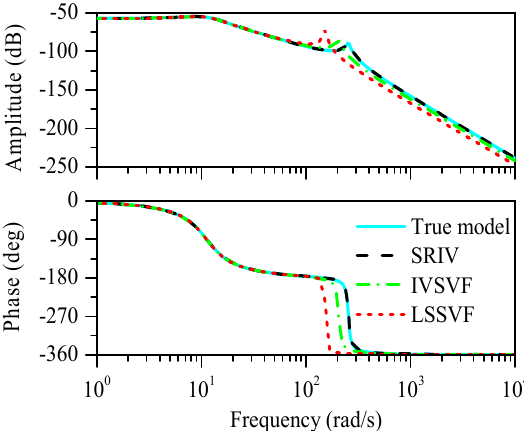
Figure 14. Bode plot of the EPS using different sampling rates.